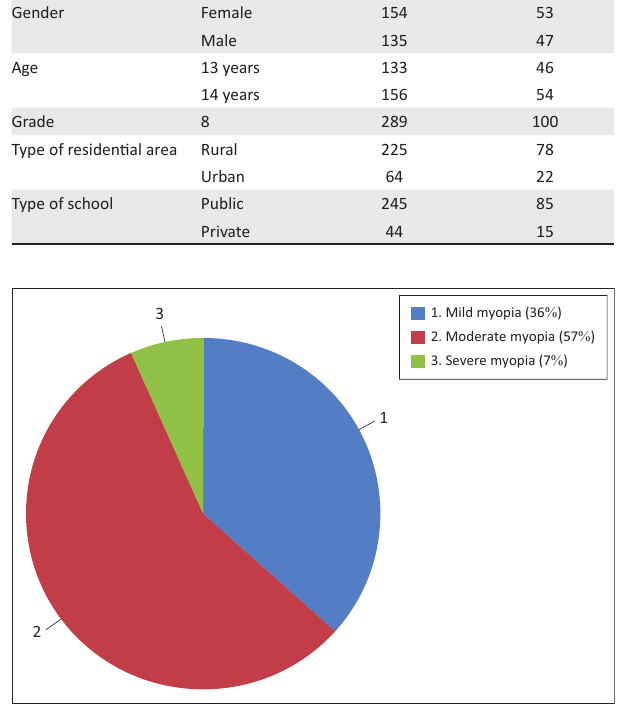
FIGURE 1 : Distribution of refractive errors in the